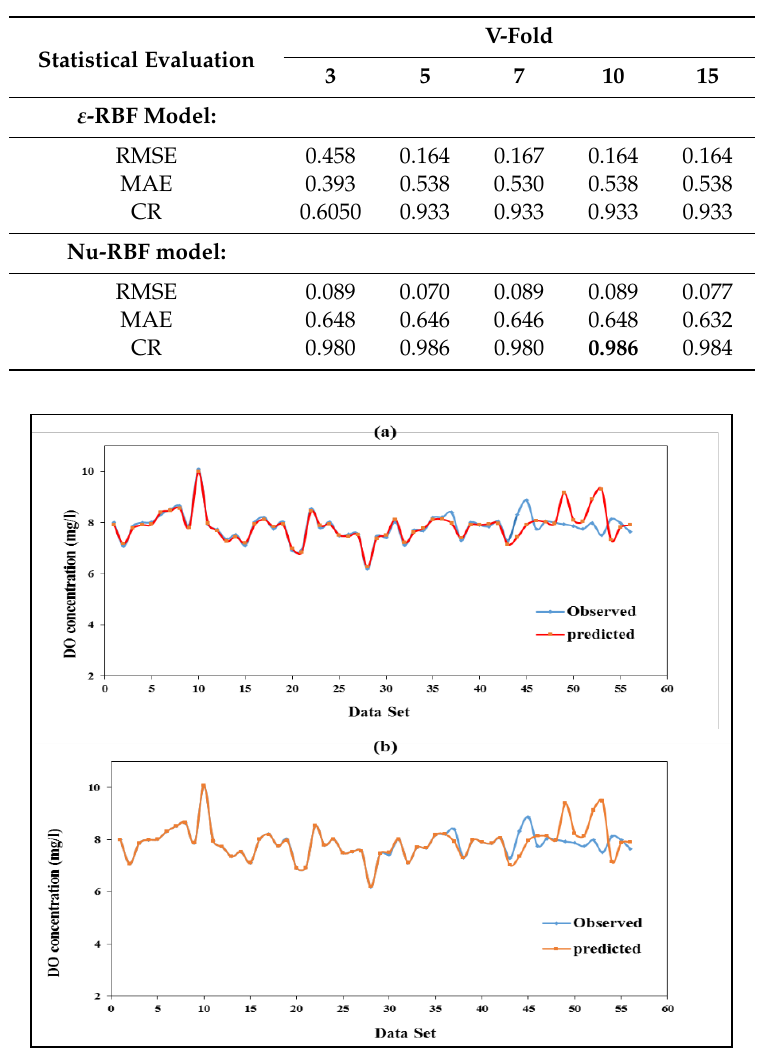
Figure 5. Comparison of actual versus predicted behavior Dissolved Oxygen (DO) concentration: ( a ) Nu-SVM type model and ( b ) Epsilon-SVM type model.